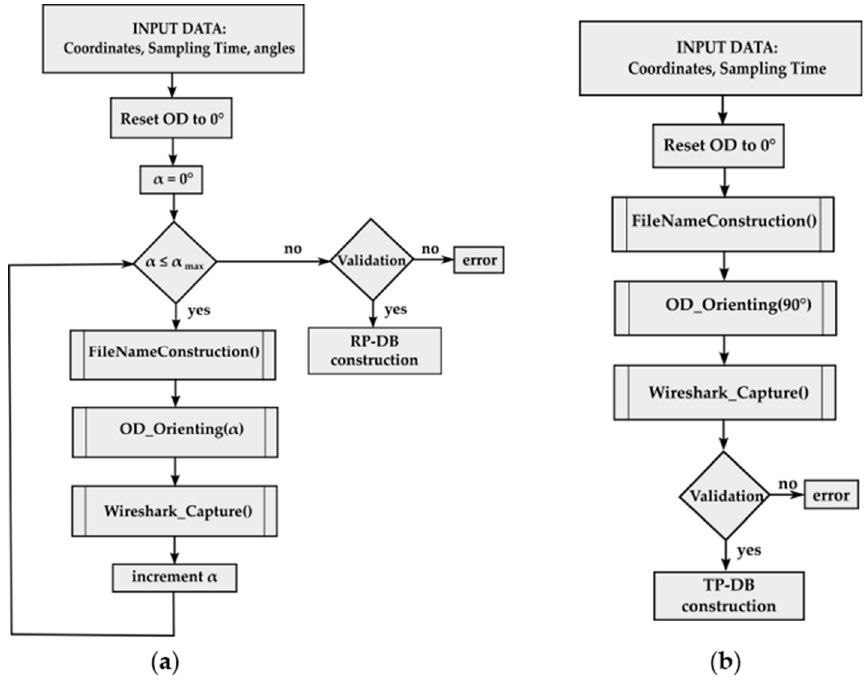
Figure 3. Algorithms for the data collection process: ( a ) Reference points-database (RP-DB) and ( b ) Test points-database (TP-DB).